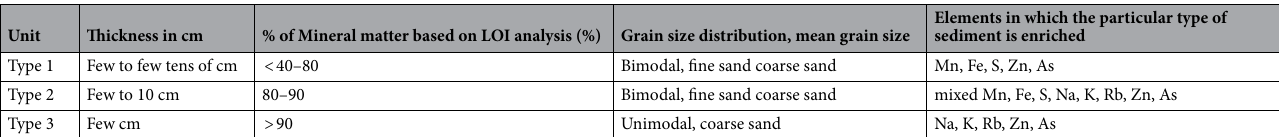
Table 1. Characteristics of various types of deposits from the mastercore